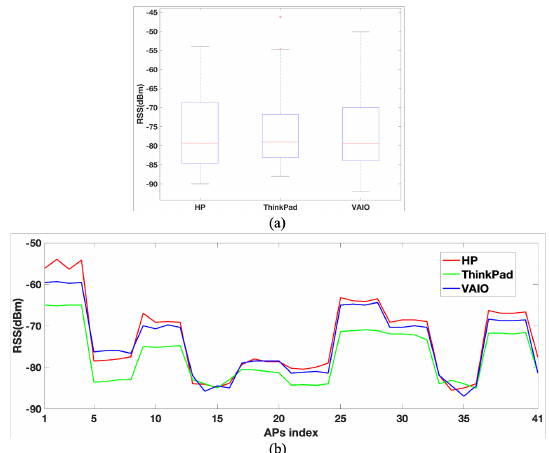
Figure 7. Example of RSS variance problem between Wi-Fi fingerprints collected on the 11th green test point by three devices. The boxplot in (a) shows the value of all measured RSS. Note that RSS value measured by ThinkPad has the smallest distribution interval among the three datasets. Samples of RSS value from 41 APs are presented in (b). It is obvious that the RSS collected by ThinkPad is the weakest among three devices, while RSS measured by HP is slightly higher than the RSS measured by VAIO. Figure. 9 Query images took by SONY cellphone on 11 green test points.